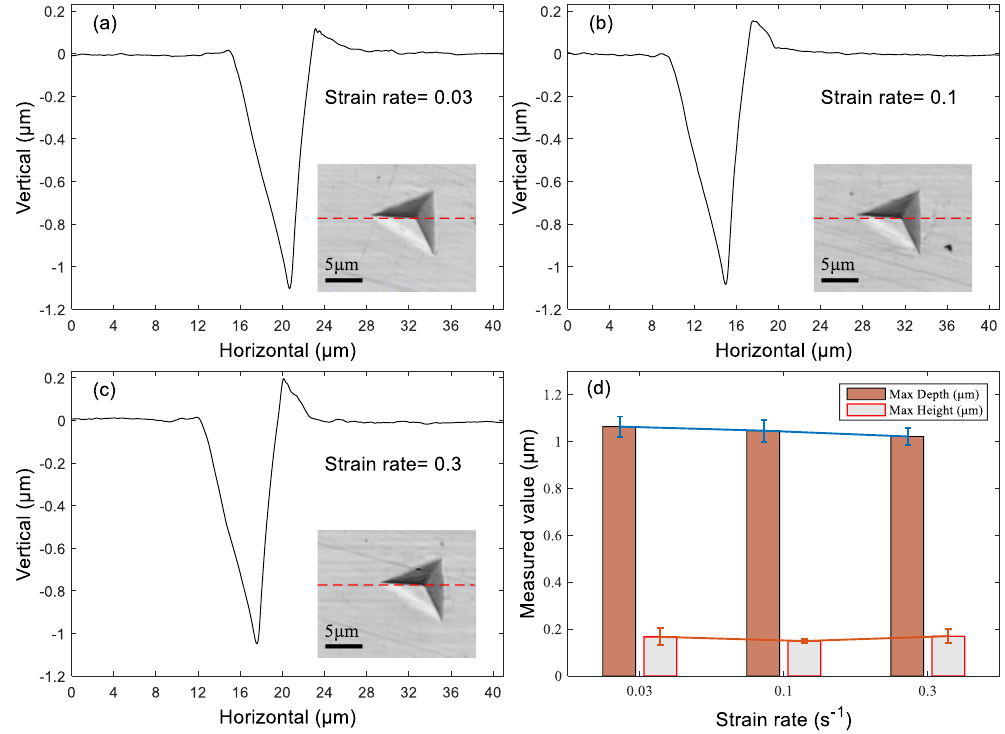
Figure 5. The morphologies and profiles at the height-horizontal section of indentation under three strain rates, ( a ) 0.03 s −1 ; ( b ) 0.1 s −1 ; ( c ) 0.3 s −1 ; ( d ) the statistics of the maximum pile–up height and the final depth.